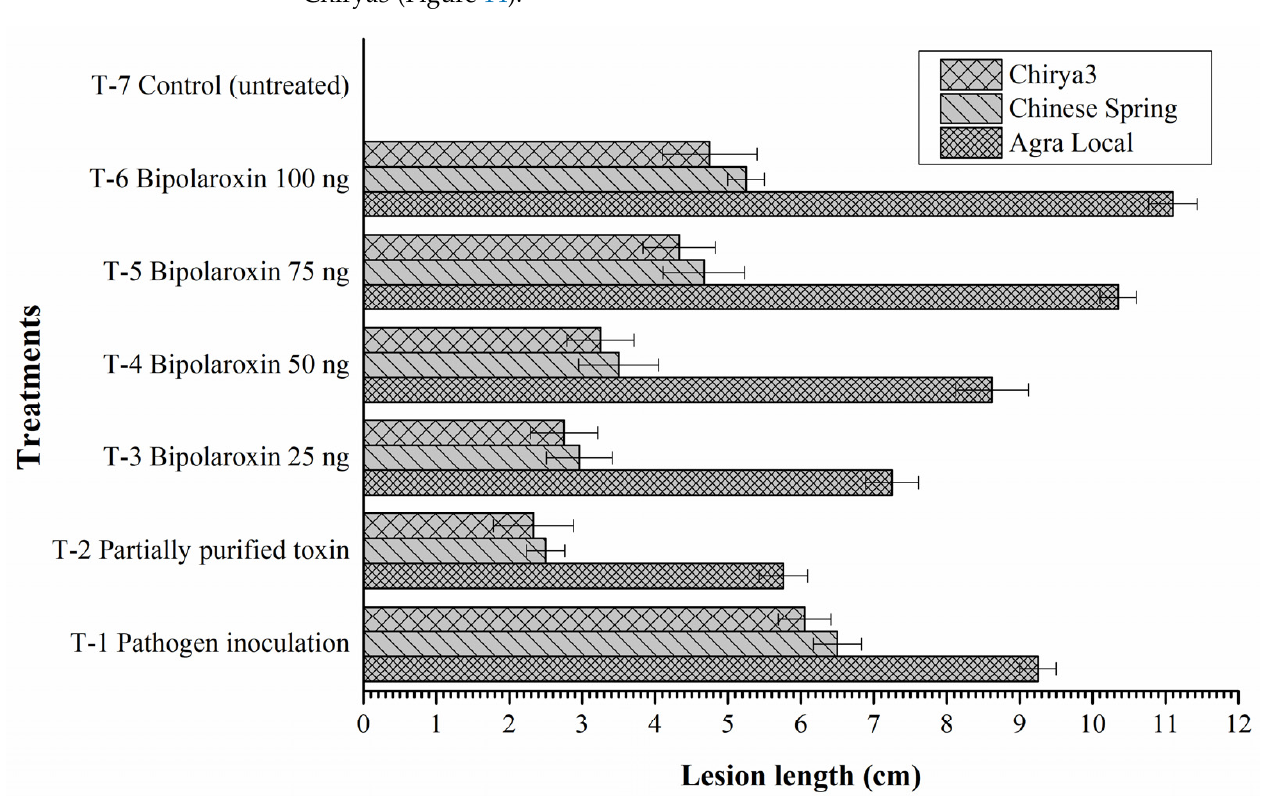
Figure 14. Effects of different treatments on lesion development in the susceptible and resistant lines/cultivars of wheat at 30 days of pathogen inoculation and infiltration of partially purified toxin obtained from B. sorokiniana as well as chemically synthesized Bipolaroxin. Data are mean ( n = 5) and vertical lines represent the standard deviation (Mean ± SD).